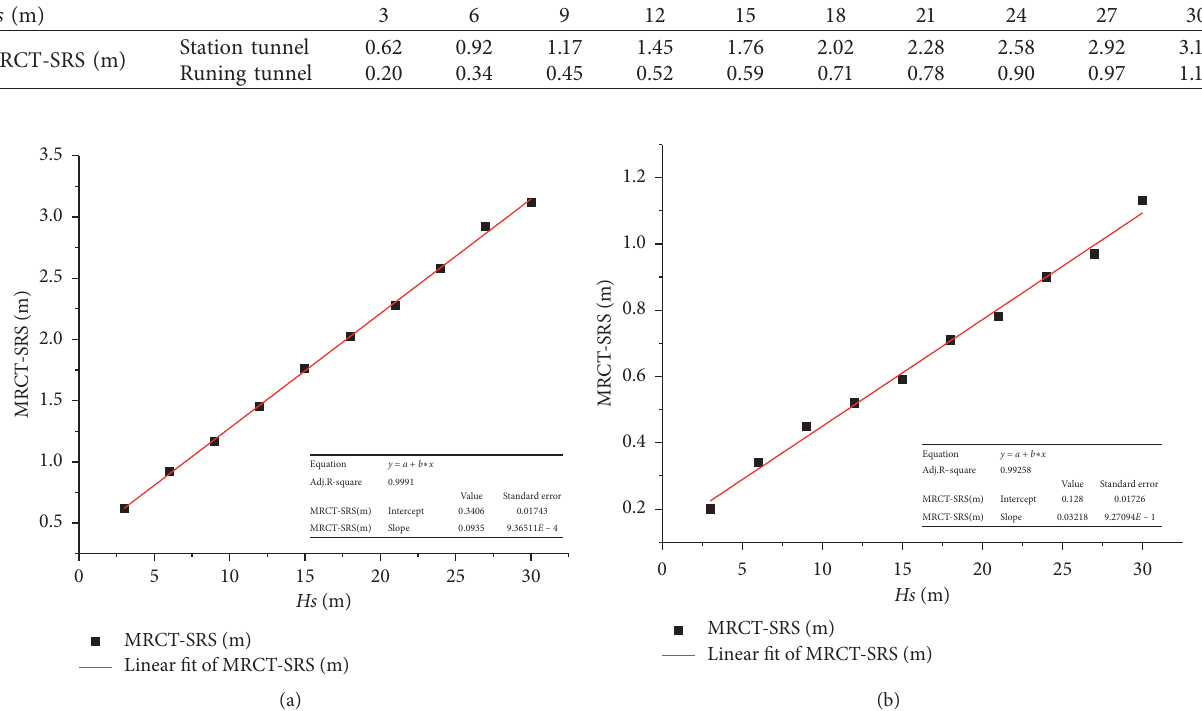
Table 3: MRCT-SRS calculation results for metro